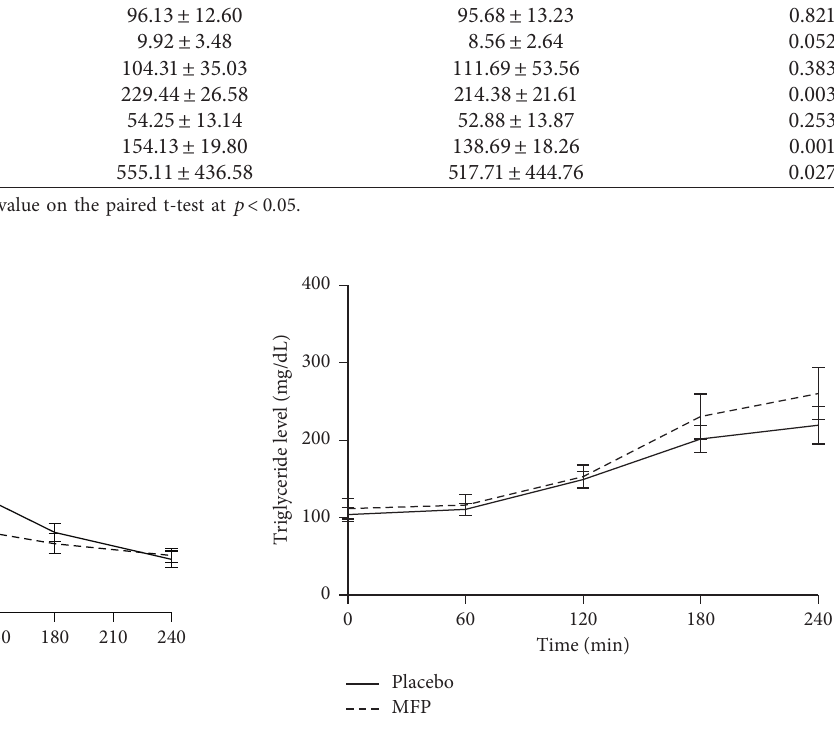
Figure 3: Blood triglyceride level after consuming two jelly samples (placebo and MFP jelly), data expressed as mean ± SE. ∗ Statistically significant ( p value <